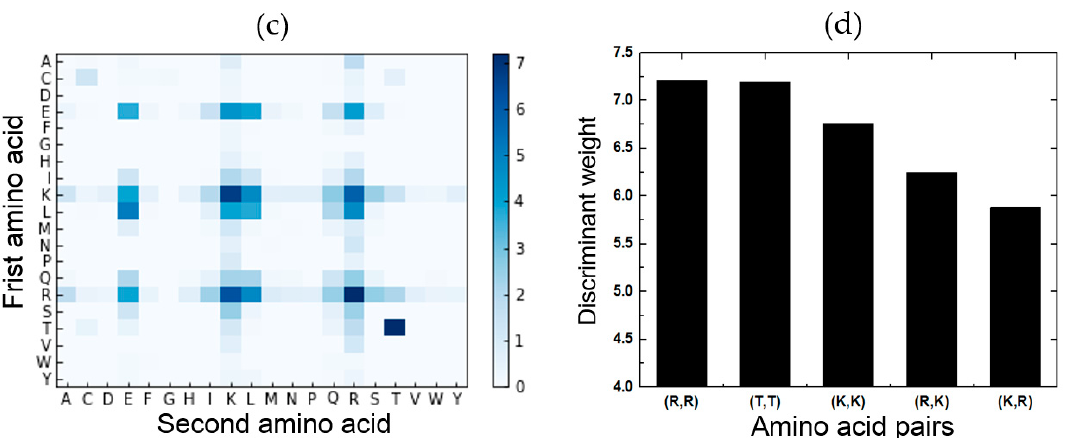
Figure 4. Feature analysis based on the features generated by PSFM-DBT. ( a ) The discriminant weights of the 400 features with d = 0. Each element in the figure represents the discriminant weight of the corresponding feature. The diagonal elements represent 20 features of amino acid composition. ( b ) The discriminant weights of the 20 amino acids according to amino acid composition. ( c ) The discriminant weights of the 400 standard amino acid pairs ( d = 1, 2, 3, 4). Each element in the figure represents the sum of the discriminant weights of the corresponding bigrams, for example, the discriminant weight of bigrams (R, R) is W (R, R) = W (RR) + W (R*R) + W (R**R) + W (R***R) , where * represents mismatch. The x-axis and y-axis represent the second amino acid and first amino acid in a bigram, respectively. ( d ) The discriminant weights of the top five most discriminant bigrams, including (R, R), (T, T), (K, K), (R, K) and (K, R).